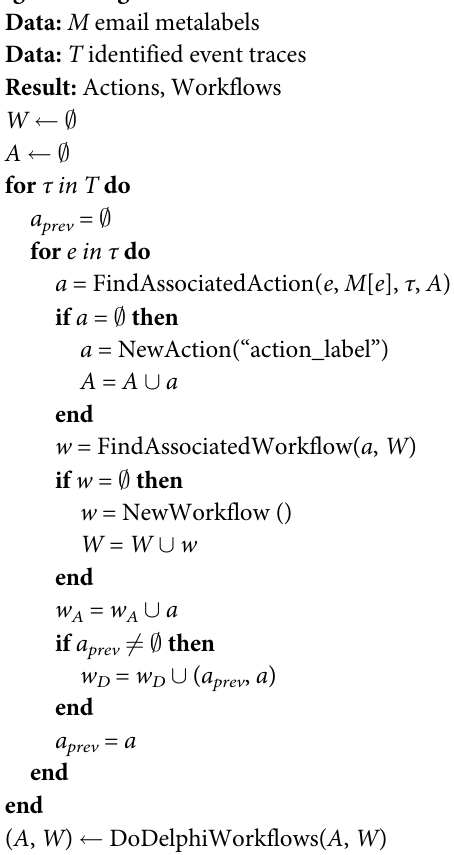
Algorithm 4 : DoWorkflowLabeling : High level description of the trace-to-workflow assignment algorithm